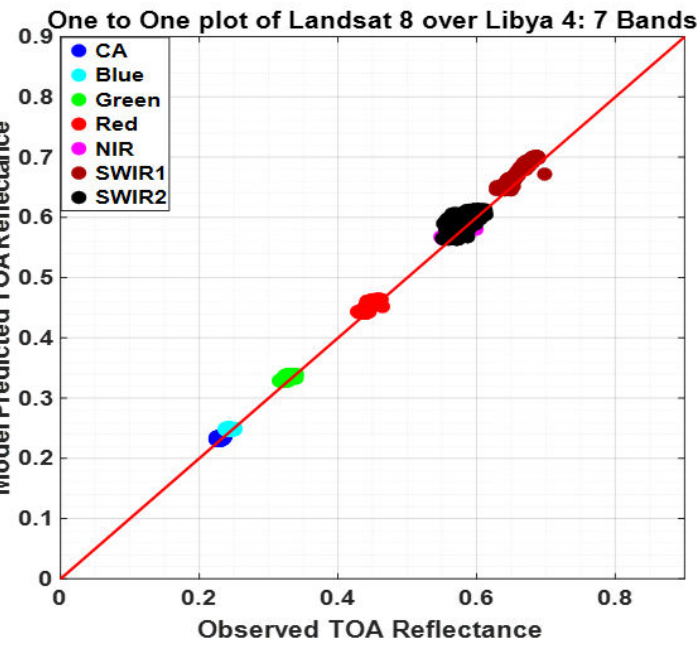
Figure 8. Comparison of the hyperspectral APICS model predicted TOA reflectance and the corre- sponding observed L8 bands. Red solid is the reference